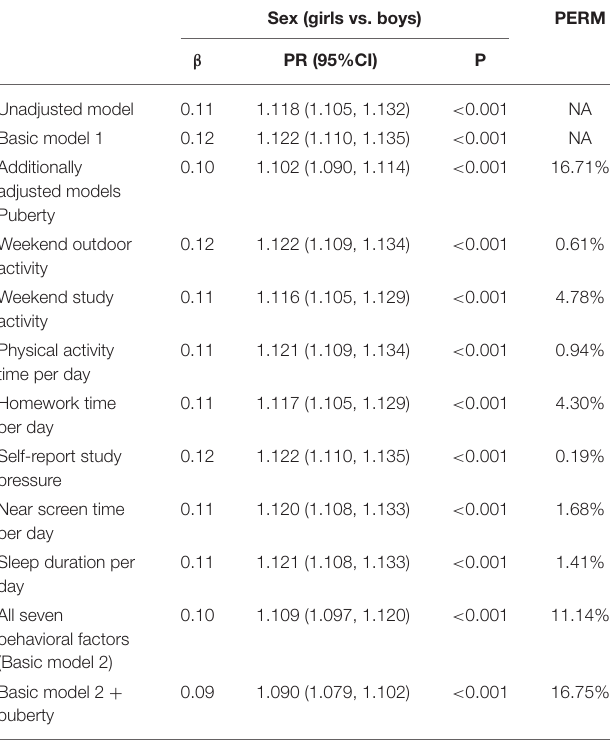
TABLE 5 | The proportion of sex disparity in myopia explained by puberty and behavioral factors, in boys and girls 11 to 18 years of age in the 2014 CNSSCH. sample size =